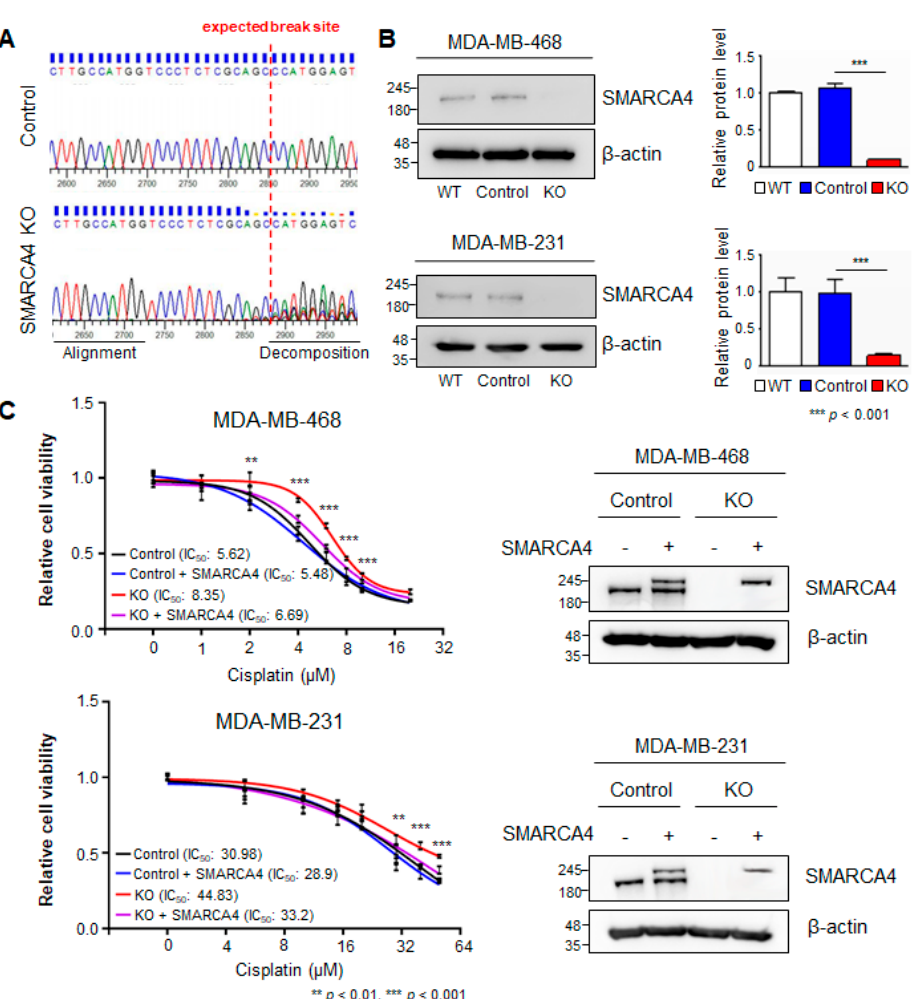
Figure 3. Effect of SMARCA4 KO on the cisplatin response of malignant breast cancer cells. ( A ) Sequence-based validation of genome editing using SMARCA4 sgRNA with the CRISPR/Cas9 system in MDA-MB-468 cells. ( B ) Western blot analysis of SMARCA4 protein expression in parental (WT) and genome-edited cell lines exposed to the CRISPR/Cas9 nontargeting control vector (control) or CRISPR/Cas9 SMARCA4 KO vector (KO). Representative Western blots from three independent biological replicates are shown. Bar plots show SMARCA4 protein expression for WT, control and KO. ( C ) Cisplatin drug response curves after 48 h in both MDA-MB-468 and MDA-MB-231 cells.